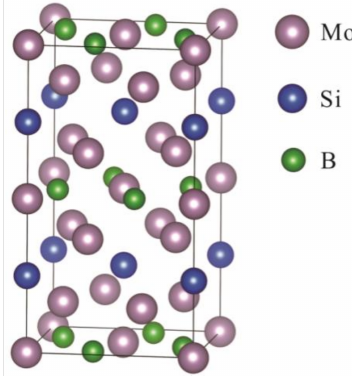
Figure 1. Crystal structure of Mo 5 SiB 2